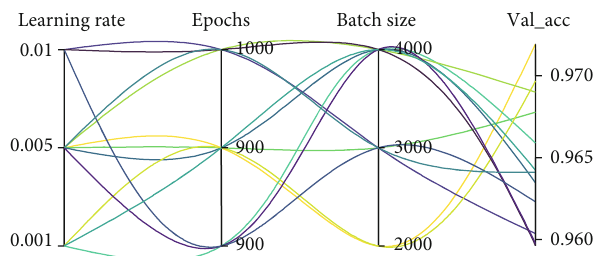
Figure 5: Illustration of NNI: di ff erent parameters set of learning rate, epochs, and batch size are examined; the combination of learning rate 0.005, iterative epochs 900, and batch size 2000 yields the optimal DNN training outcome (highest validation accuracy at